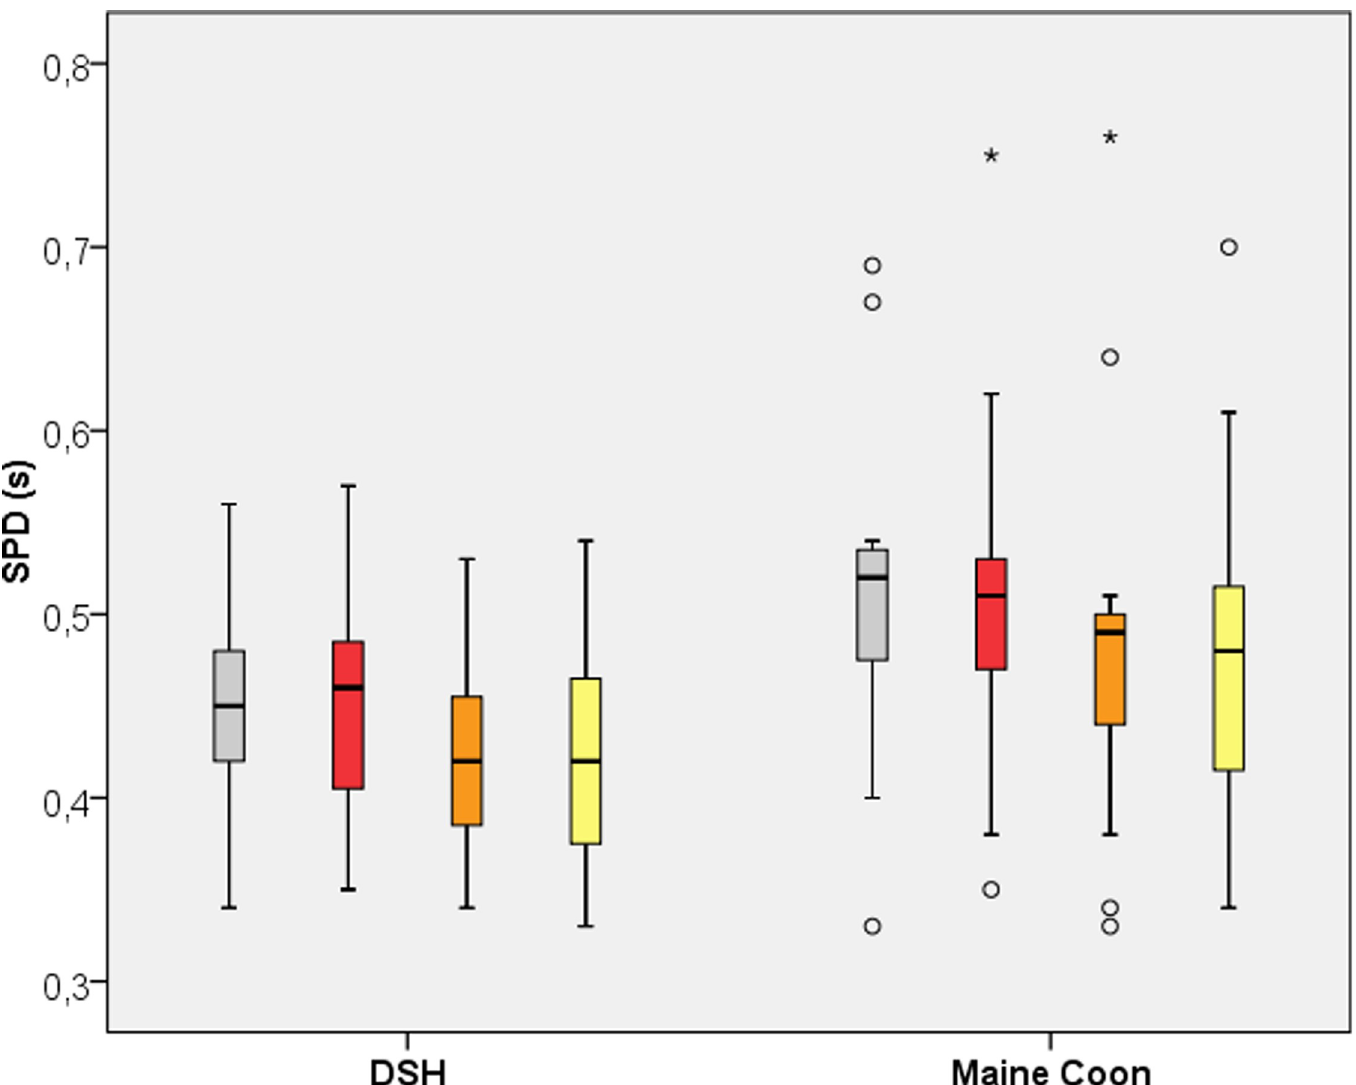
Fig 3. Boxplot of the Stance Phase Duration (SPD) for Domestic Shorthair and Maine Coon Cats. Grey = left forelimb; red = right forelimb; orange = left hind limb; yellow = right hind limb.